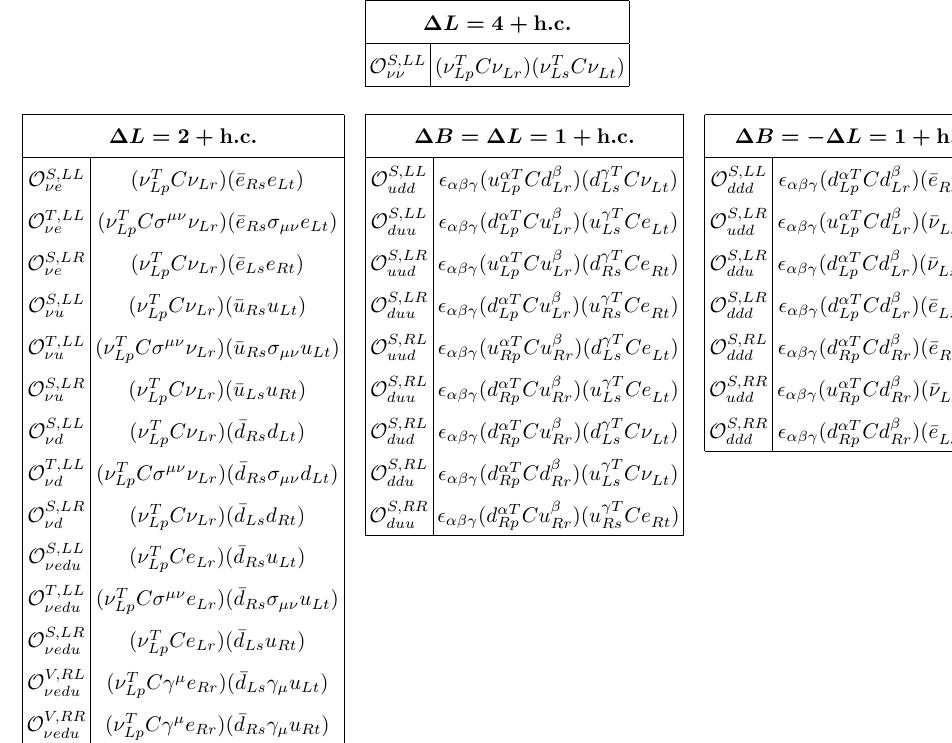
Table 4 . LEFT operators of dimension six that violate baryon and/or lepton